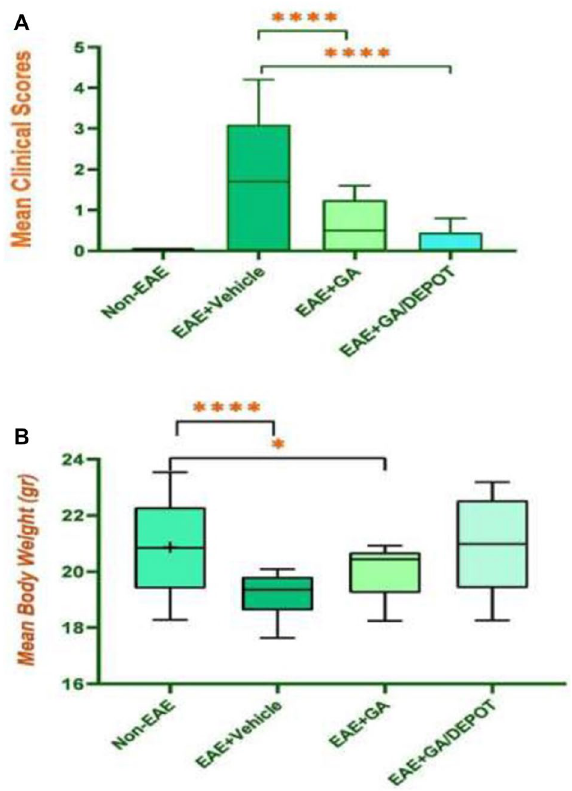
Figure 3. Comparative studies of mean clinical scores ( A ) and mean body weights ( B ) in four study groups over 28 days (p < 0.05 is shown by *, p < 0.01 is shown by ** and p < 0.001 is shown by ***) in 4 groups (GA-PLGA-CH-AL hydrogel microparticles (GMIX22) is briefly named as